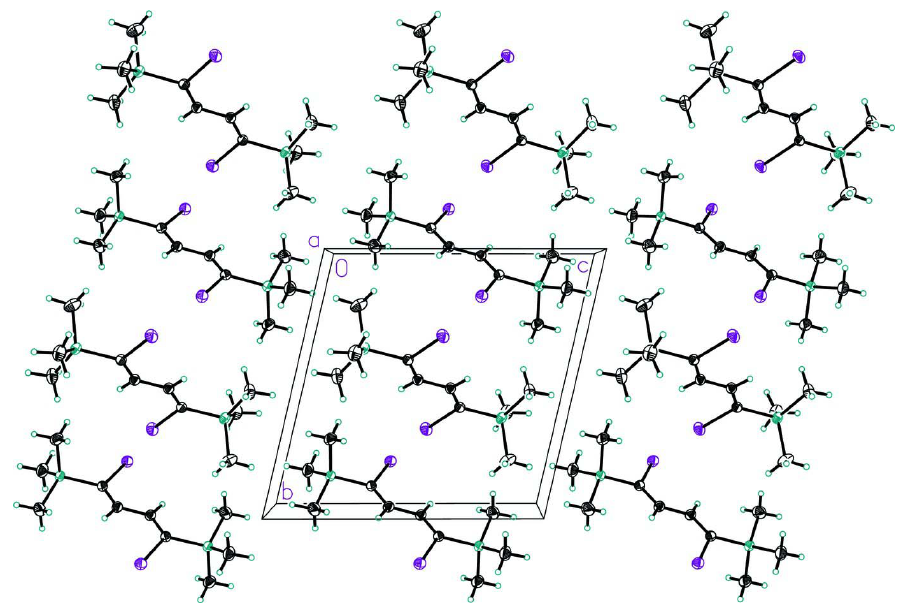
The crystal packing of the title compound, viewed down the a axis (the displacement ellipsoids are drawn at the 50% probability